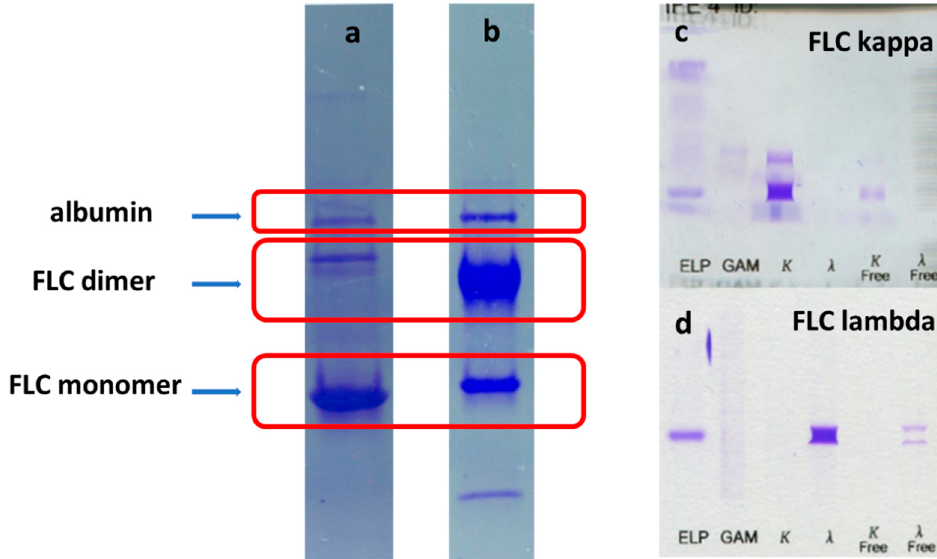
Figure 2. Representative examples of electrophoretic patterns of urine samples used in the study ( a , b ). As seen, the main component of urine samples were monomers or dimers of the immunoglobulin light chains. They were proved to be kappa ( c ) or lambda ( d ) free light chains—based on the immunofixation.